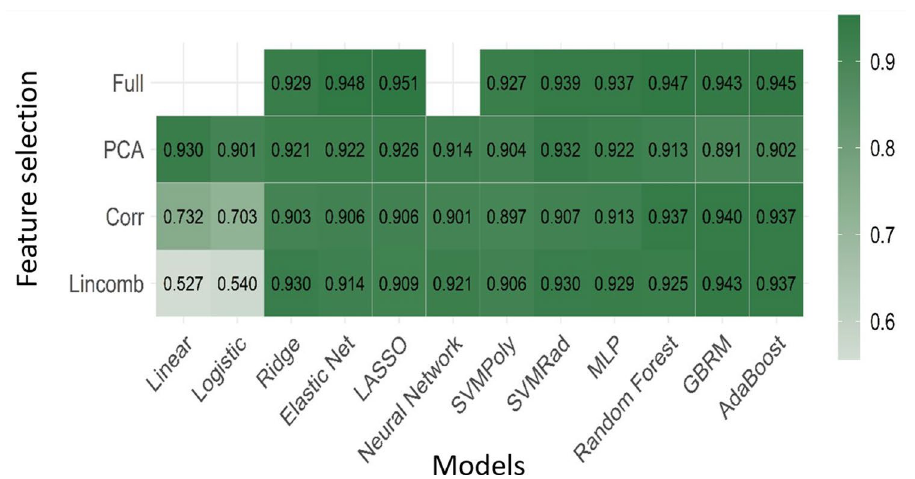
Figure 2. Diagnostic performance using FLAIR sequence. Mean AUC for all models fit using the FLAIR sequence as many of the top performing models came from this